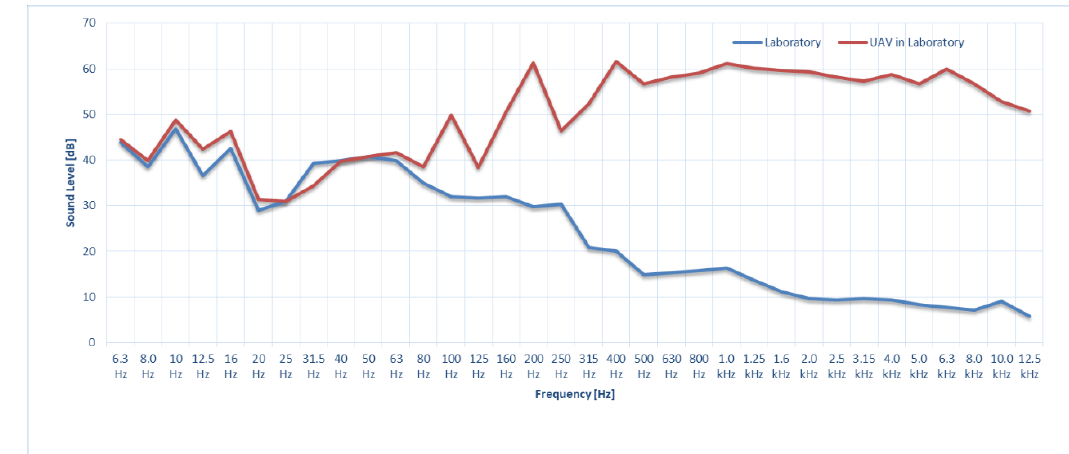
Figure 4. The background sound levels in a laboratory room in the absence of the UAV (blue line) and the presence of the UAV (red line).